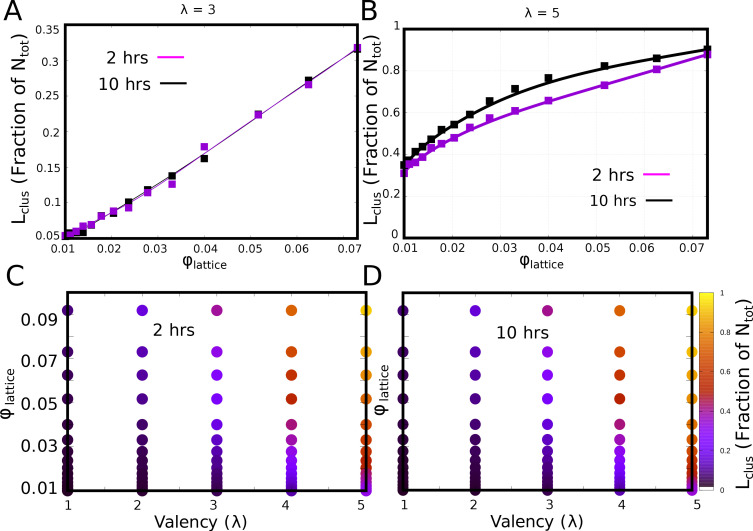
Convergence of phase diagrams.(A and B) The fraction of monomers in the largest cluster for 2 and 10 hr of actual time, for λ of 3 and 5, respecively. (C and D). The λ-ϕ phase diagram at the end of 2 and 10 hr of simulation time, respectively, showing very little difference.